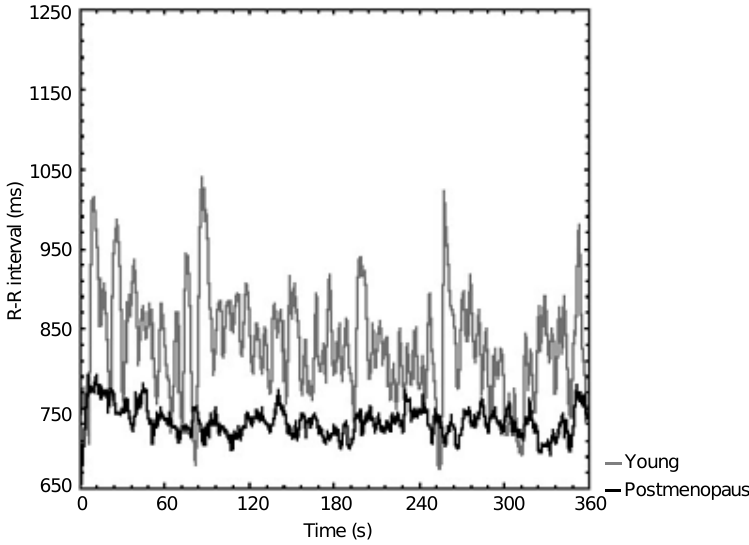
Figure 2. R-R interval, in ms, for the young (gray) and postmenopausal (black) volunteers under resting conditions in the sitting position (N =